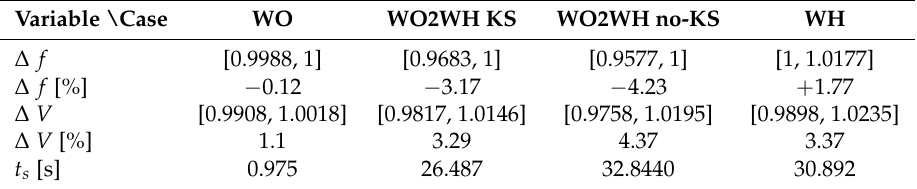
Table 1. Simulation results